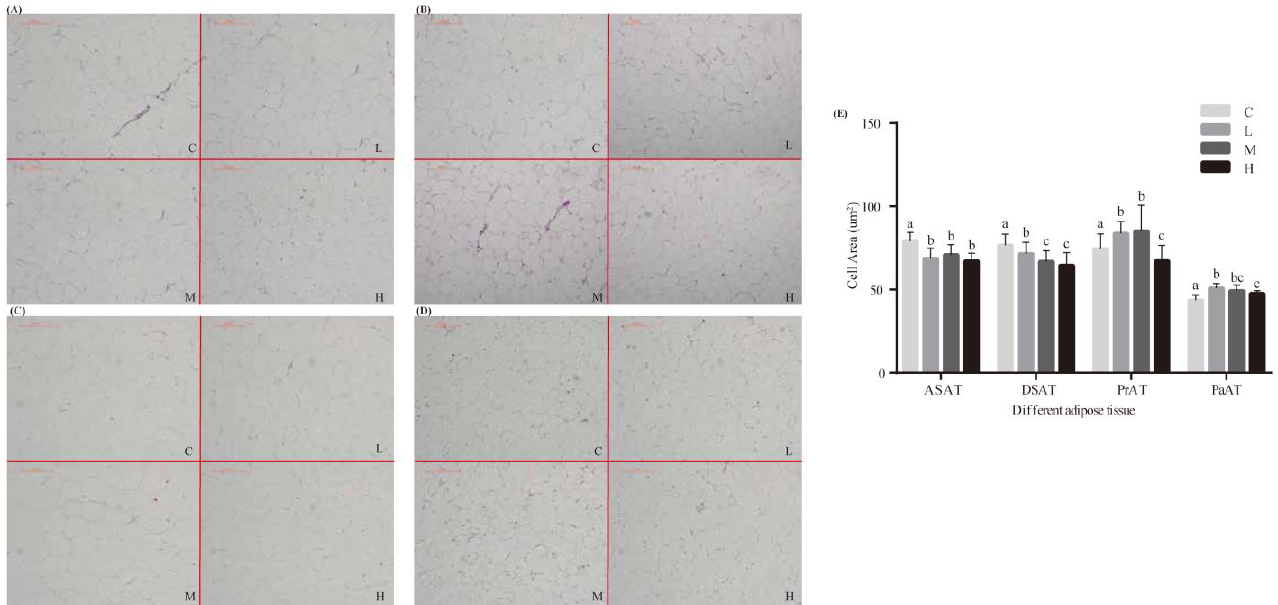
Figure 1. Effects of Agriophyllum squarrosum on different adipose tissue histomorphologies and cell areas in Tan lambs. C, control; L, 10% A. squarrosum diet; M, 20% A. squarrosum diet; H, 30% A.